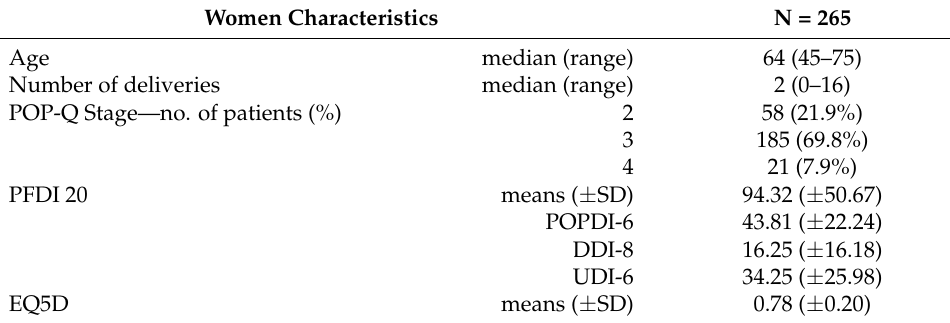
Table 1. Description of the population before cystocele